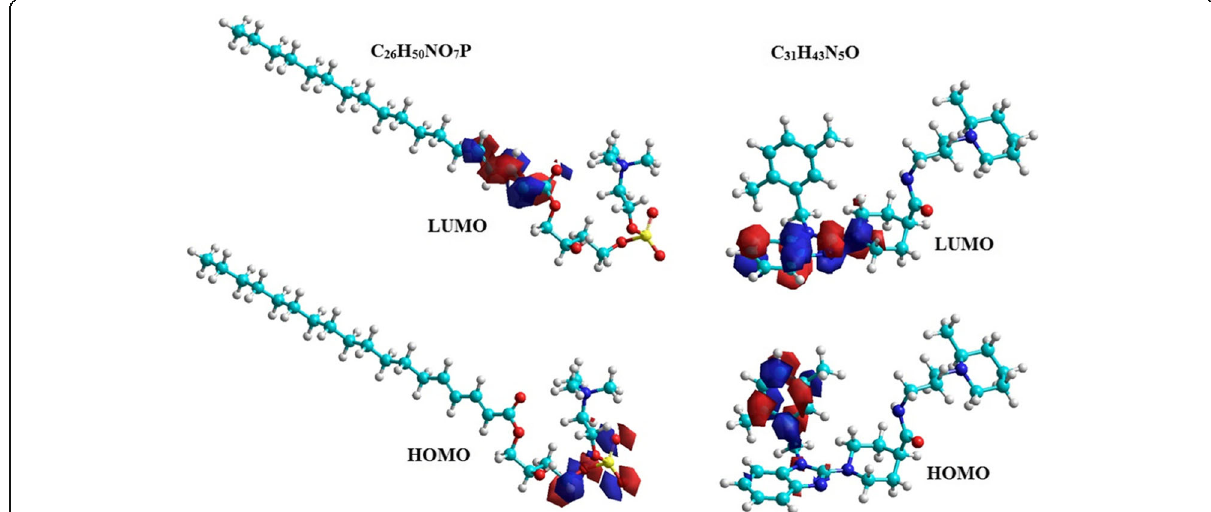
Fig. 17 LUMO and HOMO distributions for C 26 H 50 NO 7 P and C 31 H 43 N 5 O